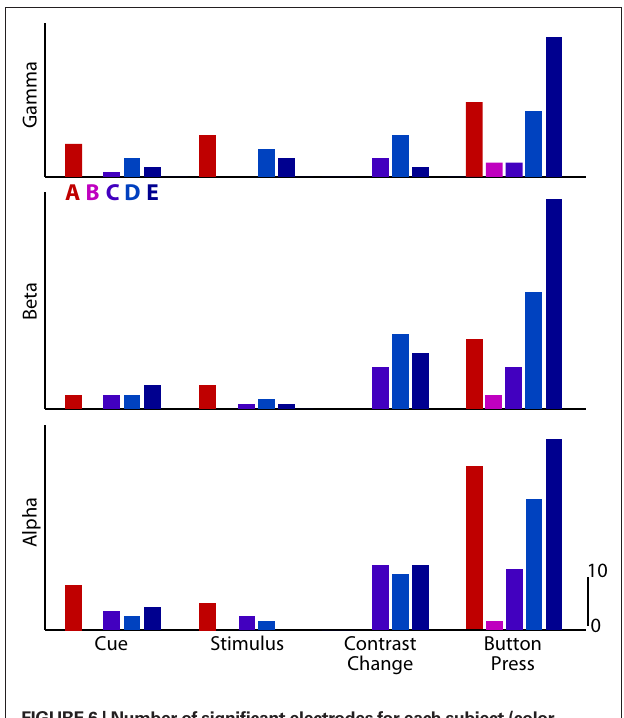
FIGure 6 | Number of significant electrodes for each subject (color- coded columns; Subjects A–e) and experimental state (grouped columns), for gamma, beta, and alpha bands